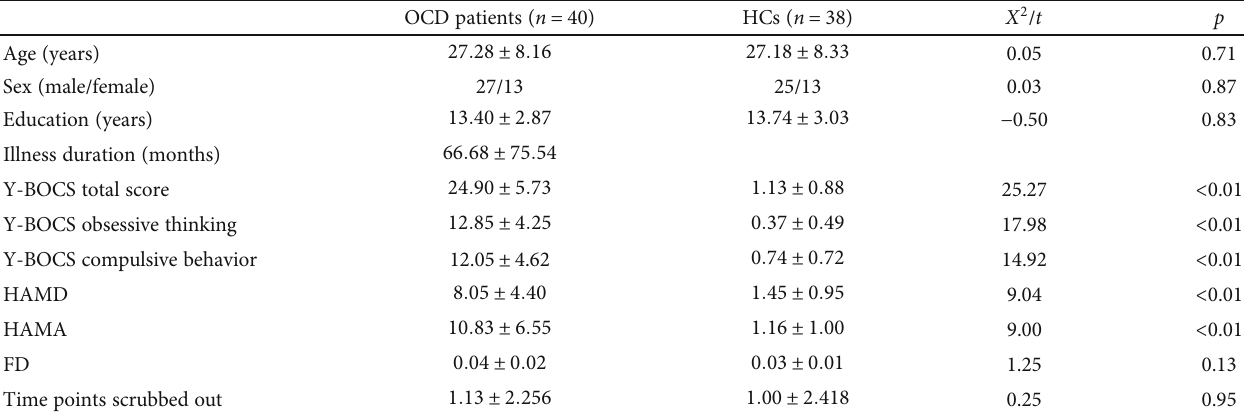
Table 1: Demographic and clinical characteristics of participants.